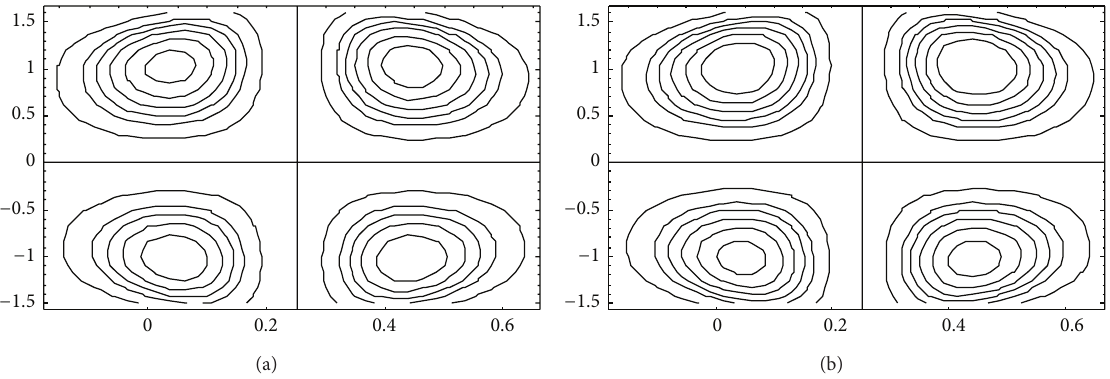
Figure 5: Streamlines when 𝐸 1 = 0.2 , 𝐸 2 = 0.1 , 𝐸 3 = 0.1 , 𝜀 = 0.1 , 𝛿 = 0.01 , 𝑡 = 0.0 , 𝑅 = 0.01 , 𝑀 = 1 , 𝜆 1 = 0.1 , and 𝜆 2 = 0.05 . (a) 𝛽 = 0.01 and (b) 𝛽 = 0.05 .